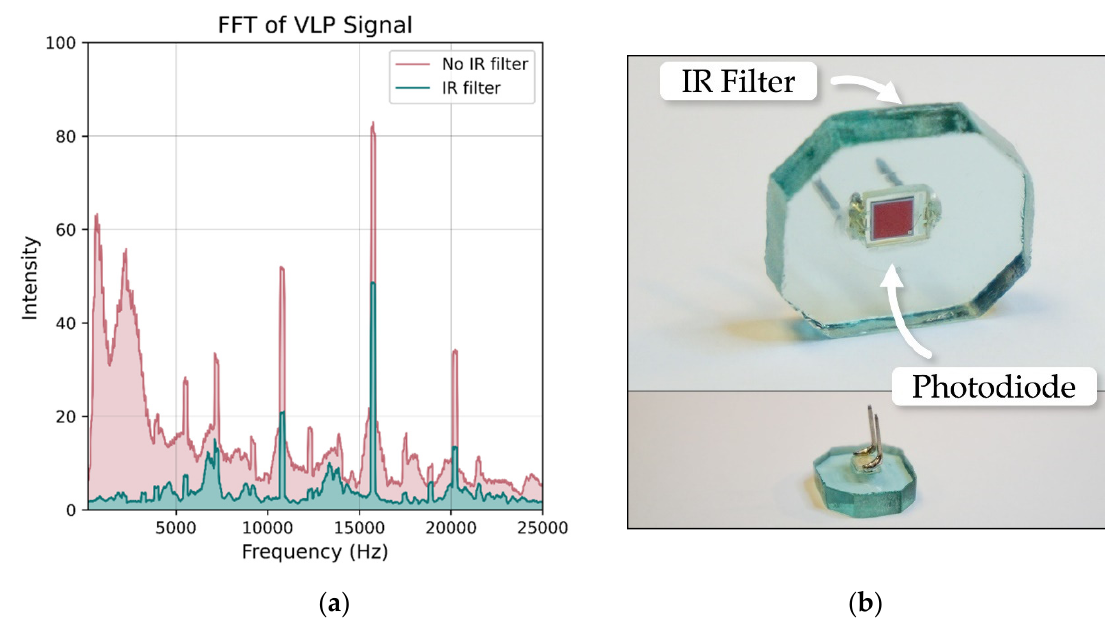
Figure 3. The IR signals from the Vive base stations caused interference with the VLP receivers as shown in ( a ). The Vive signal added substantial noise at frequencies lower than 4 kHz and altered the intensities of the luminaire peaks. To prevent interference, an IR-rejecting photodiode was used and then placed behind IR-rejecting glass ( b ). The combination of the two eliminated the interference.